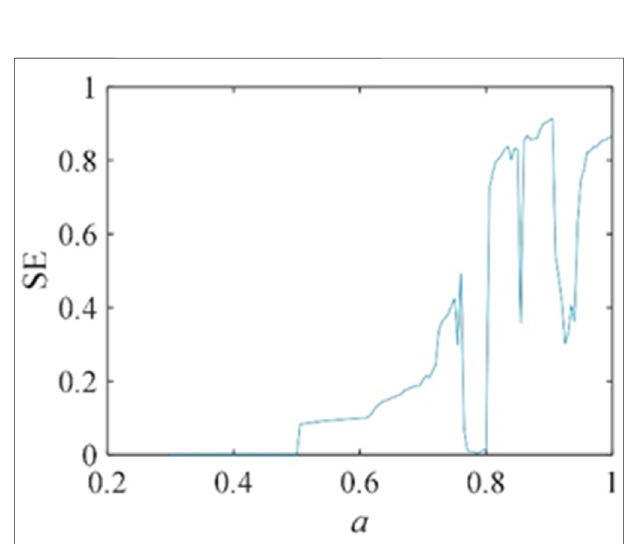
FIGURE 5 | SE complexity diagrams of the map when the parameter a